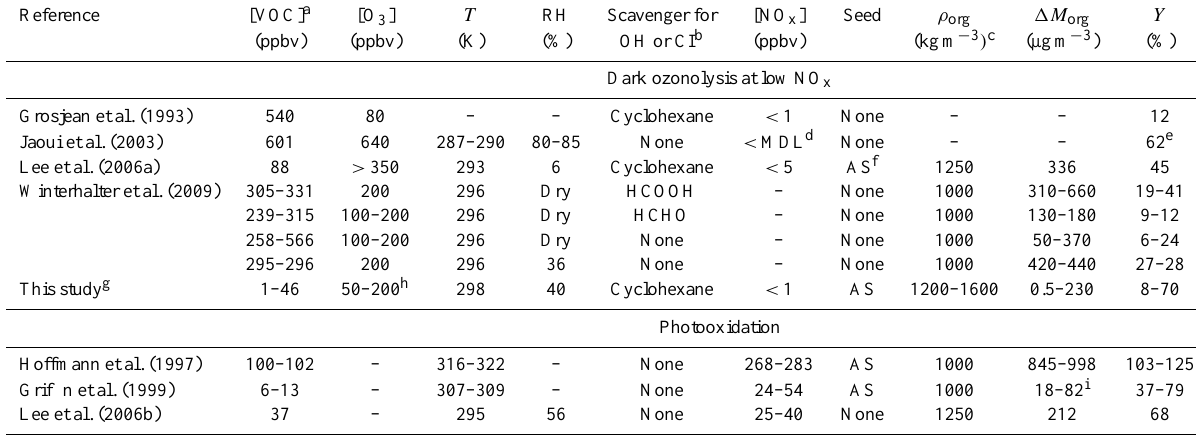
Table 1. Compilation of experimental conditions and particle mass yields reported in the literature for β -caryophyllene oxidation.